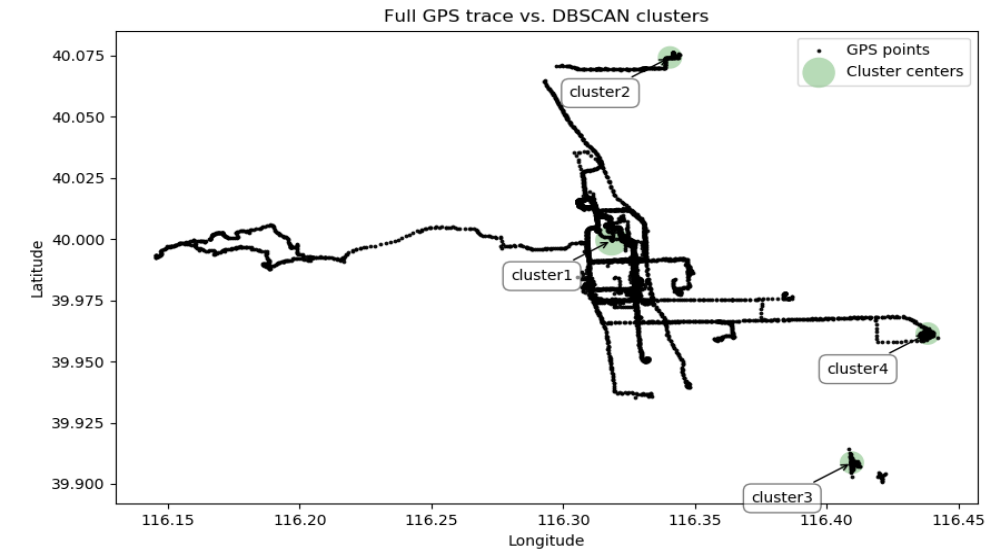
Figure 1. The illustration of user trajectory clustering.